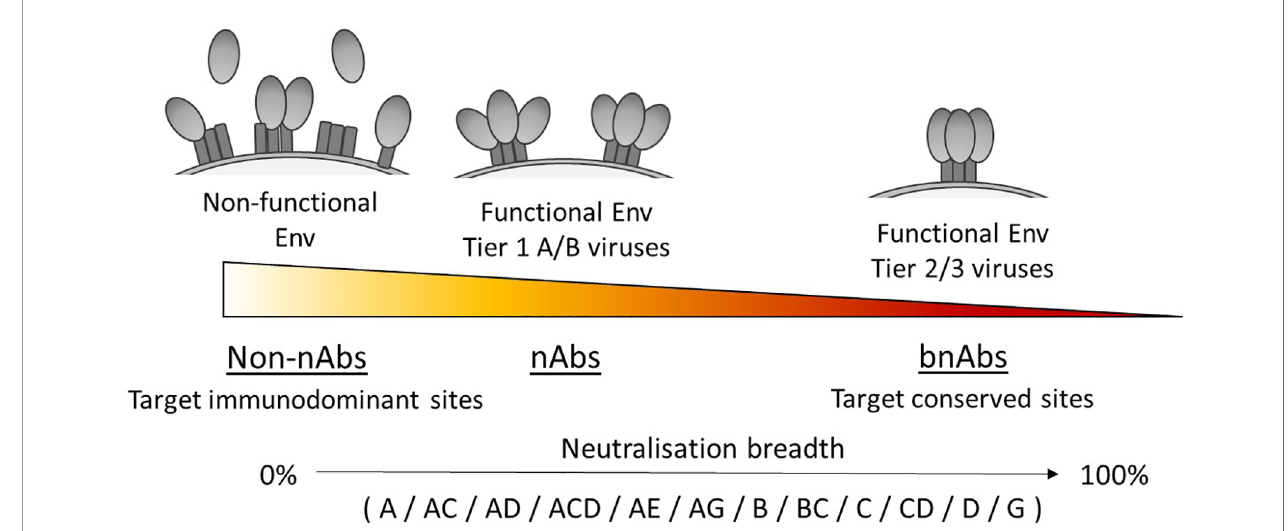
FIGURE 1 | Neutralisation breadth corresponds with the ability to target functional Env trimers in a closed conformation. Tier 1A, tier 1B and tier 2/3 viruses have a predominantly open, intermediate and closed Env trimer conformation respectively and relates to their susceptibility to neutralisation, with tier 2/3 viruses being harder to neutralise. Antibodies that can neutralise tier 2/3 viruses from multiple clades (listed here in alphabetical order) have increased breadth by targeting conserved sites on the Env